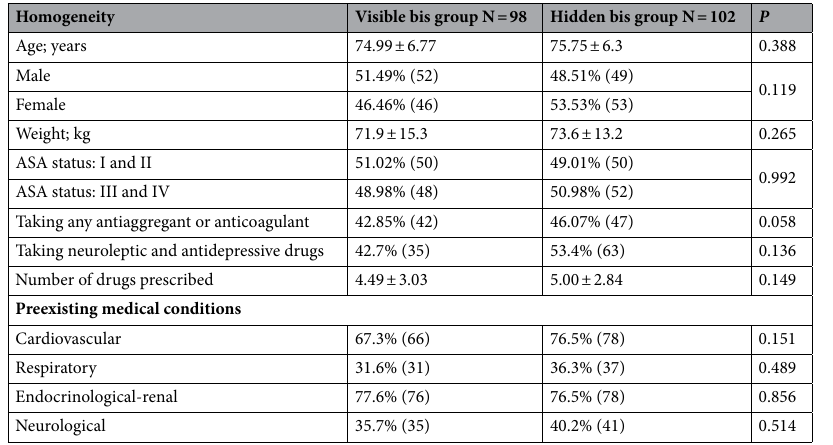
Table 1. Homogeneity and comparison of demographic data and comorbidities between groups. Patient characteristics at entry of the trial. Values are number (%) or mean ± SD. ASA indicates patients’ scores on the ASA anaesthesia risk assessment scale.